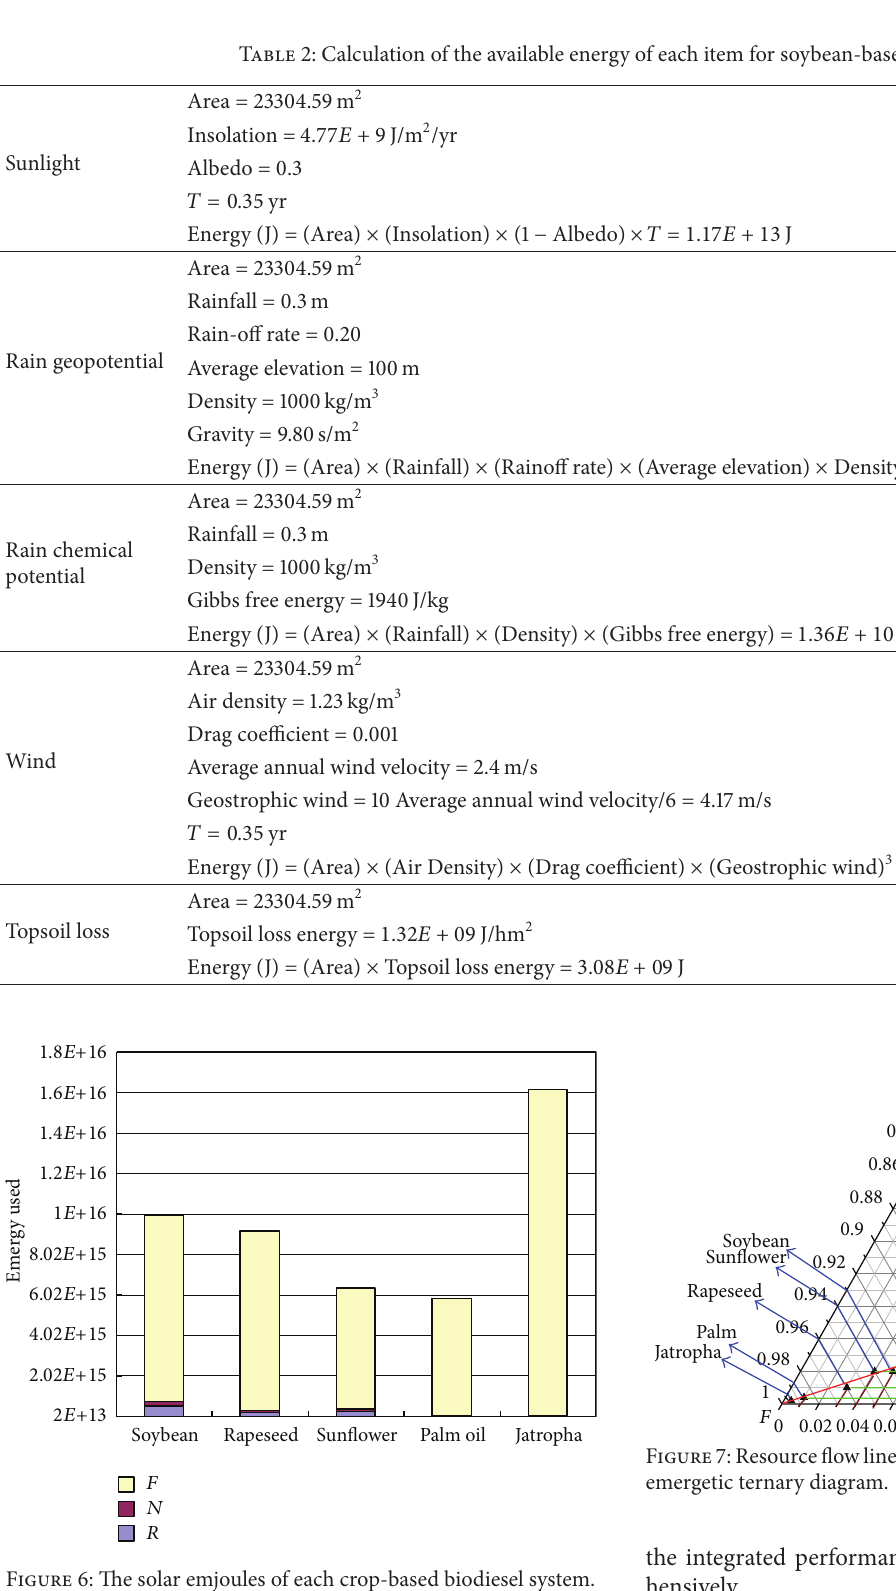
transformities and the importance (weights) of the emergy indices; Section 3 proposes a novel methodology to analyze